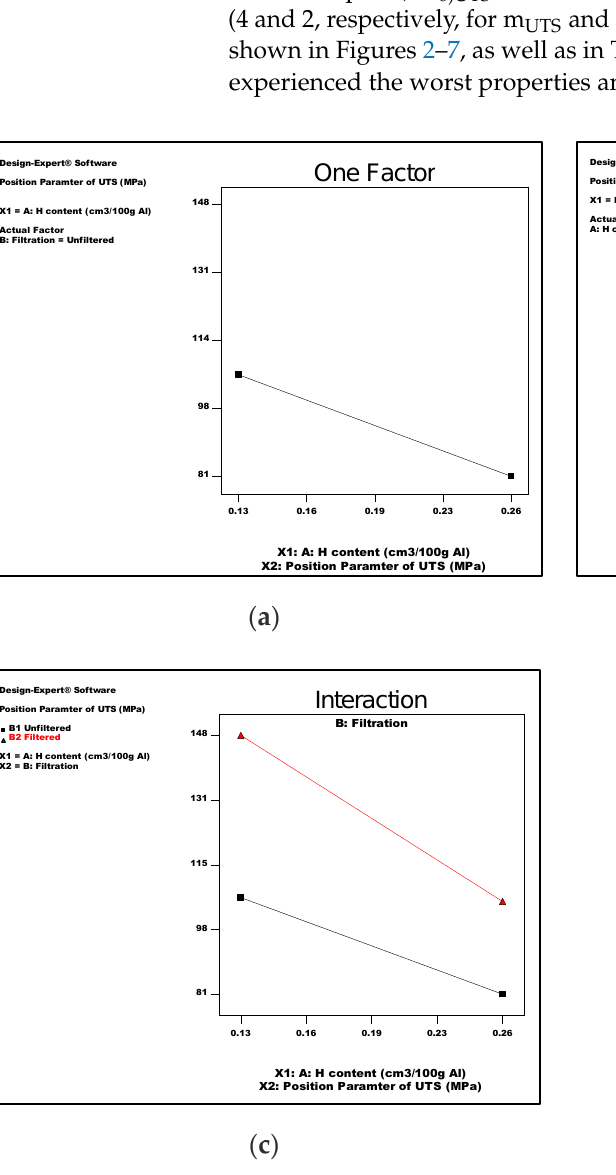
Figure 6. Influence of ( a ) hydrogen level, ( b ) filtration ( c ) the interaction between hydrogen level and filtration on x 0)UTS.